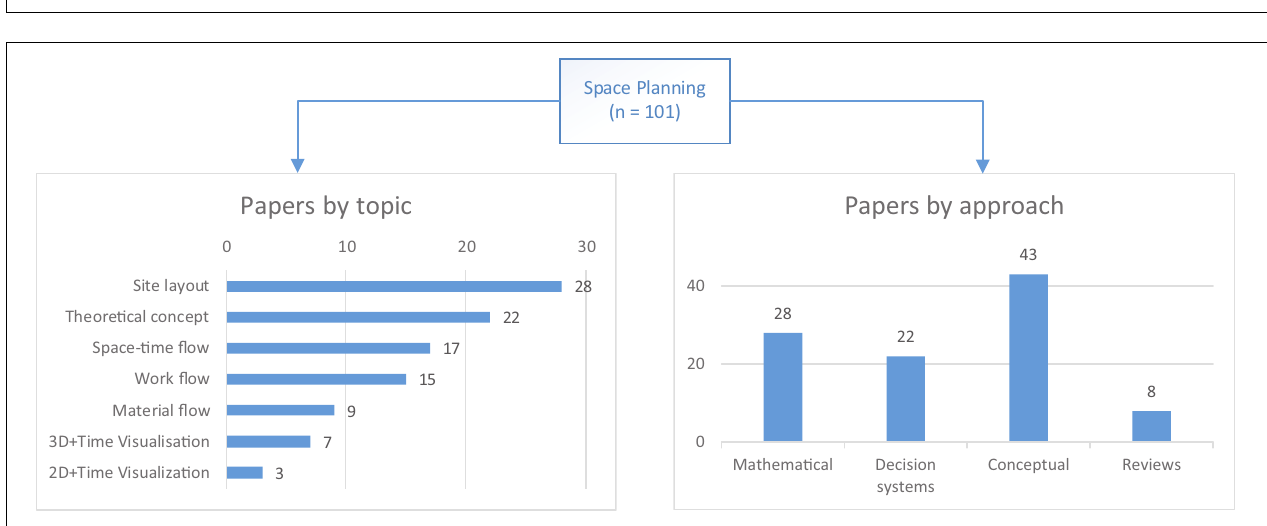
FIGURE 2 | Interest index model.